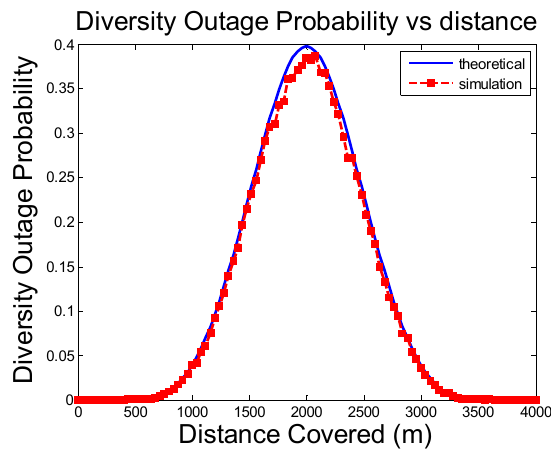
Figure 6. Theoretical and simulated outage duration for a dual diversity scheme vs. distance covered.